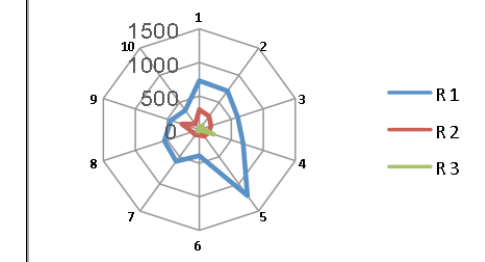
Figure 3. Course 5: Students access distribution per type of resource (R1, R2, R3) for every lab experiments